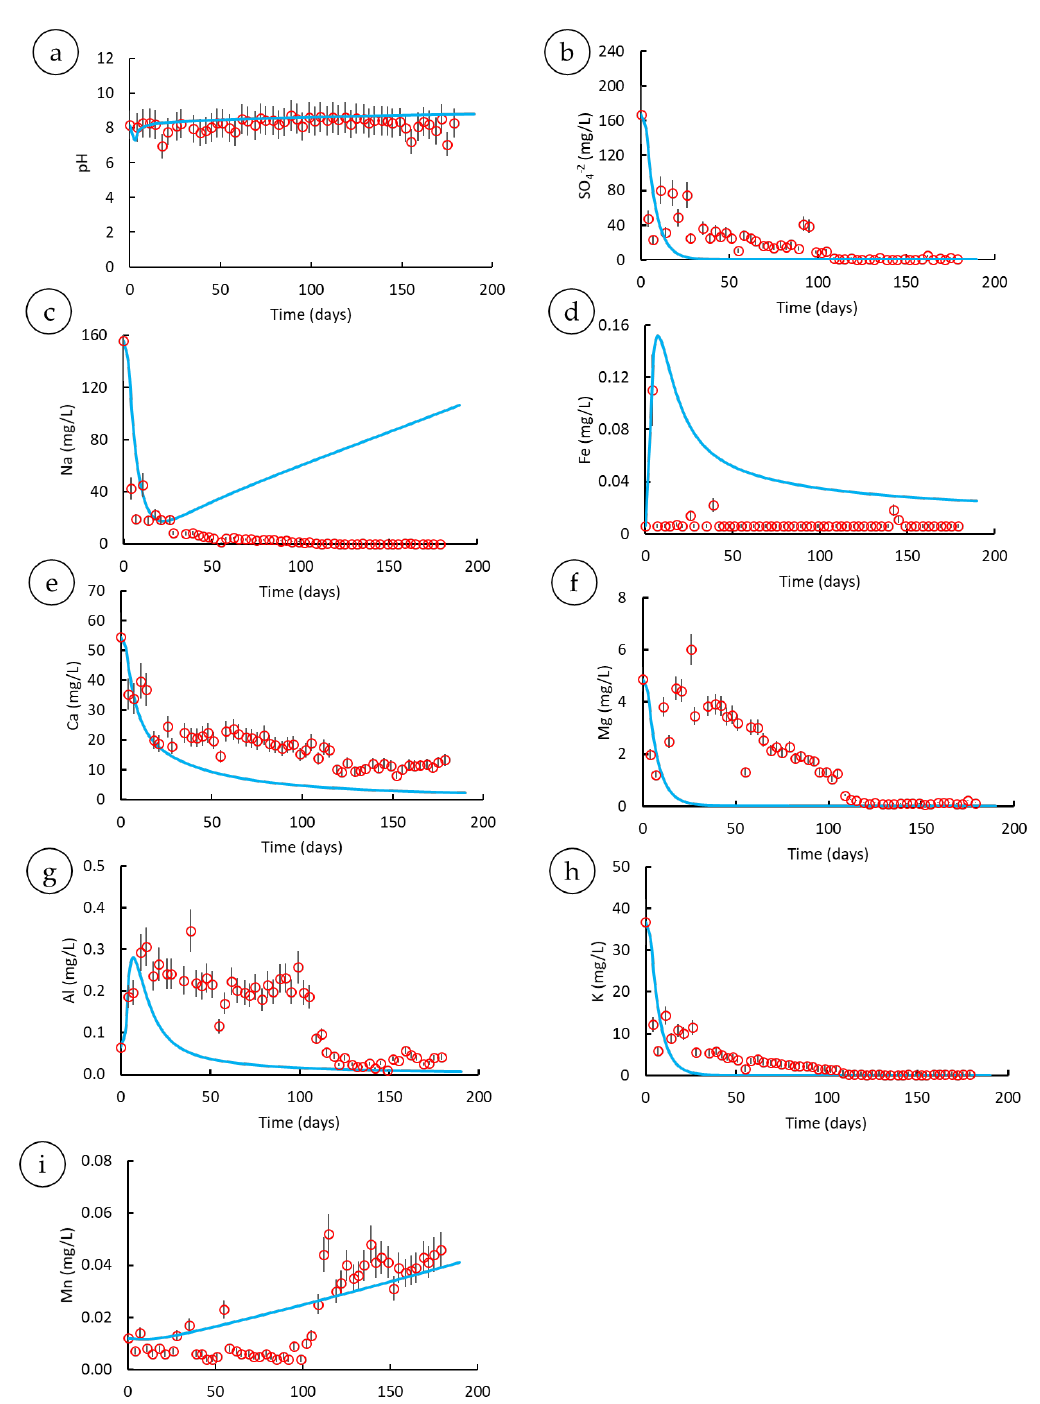
Figure 7. Weathering cell test D3 and PHREEQC modeling results. ( a ) Experimental and simulated results of the pH. ( b ) Experimental and simulated results of sulfate. ( c ) Experimental and simulated results of sodium. ( d ) Experimental and simulated results of the total dissolved iron. ( e ) Experimental and simulated results of total dissolved calcium. ( f ) Experimental and simulated results of total dissolved magnesium. ( g ) Experimental and simulated results of total dissolved aluminum. ( h ) Experimental and simulated results of total dissolved potassium. ( i ) Experimental and simulated results of total dissolved manganese.